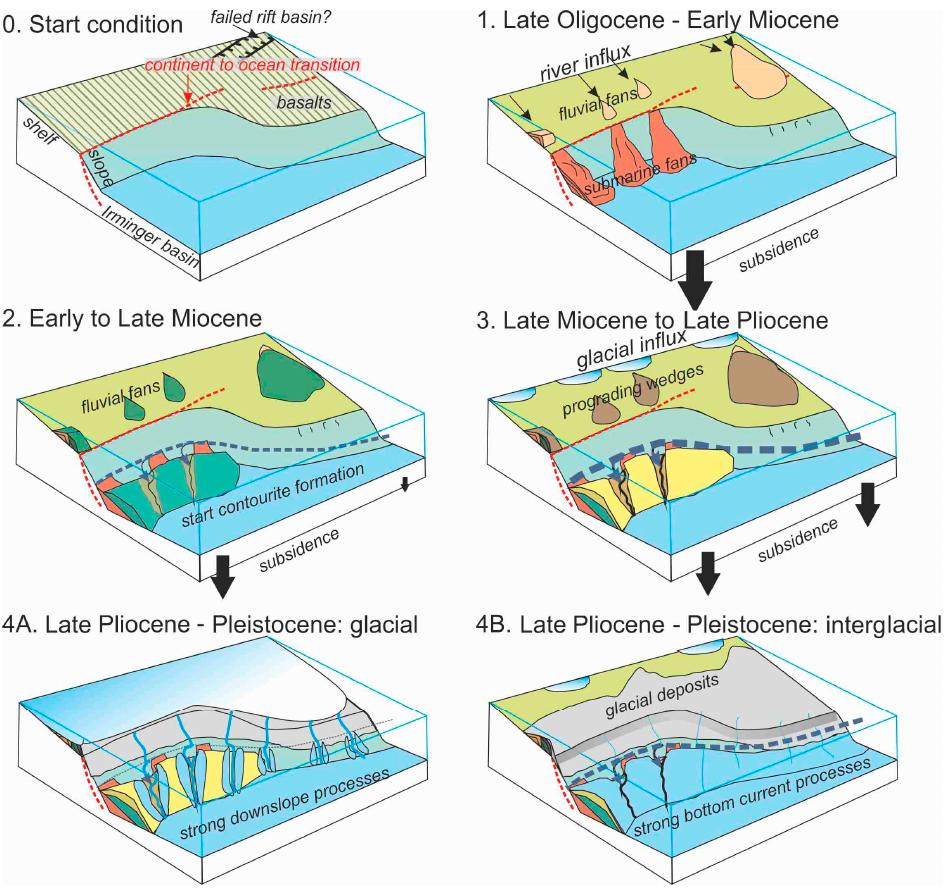
Figure 7. Shelf and slope evolution model of the SE Greenland margin. The black, vertical arrows represent subsidence of the Irminger Sea basin and their relative size, indicating the degree of subsidence. Stage 0 represents the starting position in the Eocene with the already wider northern shelf and narrower southern shelf. Stage 1 represents the development of submarine turbidite fan complexes along the southern, narrower shelf in the Late Oligocene—Early Miocene. Stage 2 represents the start of bottom current activity in the Early to Late Miocene. These bottom currents partly tend to deepen under topographic steering by the previously formed fan complexes. Stage 3 represents a period with an overall increase in the bottom current strength and the initial development of tidewater glaciers in the Late Miocene—Late Pliocene. Stage 4 is divided in a part A and B representing the glacial and interglacial periods respectively. During stage 4A the glaciers reach onto the shelf and shelf edge, and large quantities of sediment flow downslope in the form of turbidity currents. These sediments are deposited as channel levees and turbidites on the lower slope and in the Irminger Sea basin. Bottom current activity is subdued in this stage. During stage 4B the glaciers have receded and left behind a thick glacigenic sediment cover on the shelf. Substantially less sediment reaches the shelf break. The much stronger bottom currents redistributed the previously deposited turbidite deposits into the form of contourite deposition. The contourite ridges lead to formation of downward current branches into the